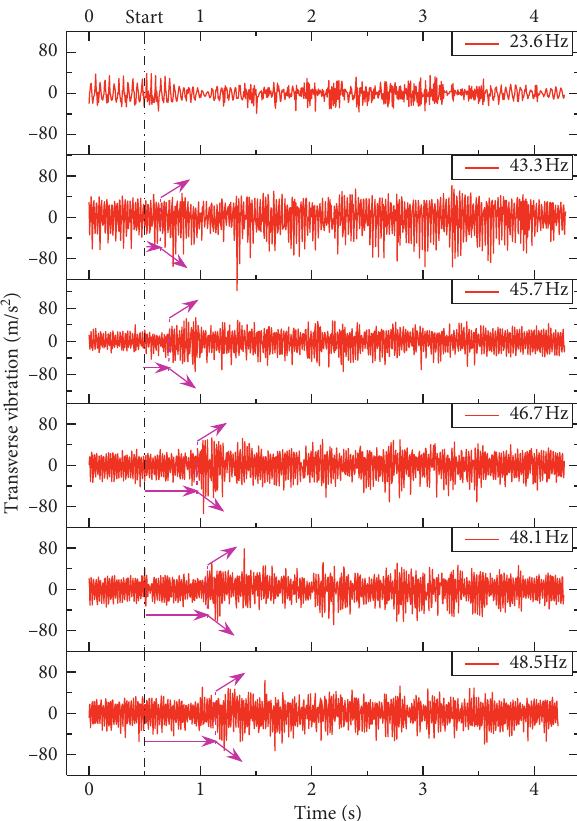
Figure 12: Transverse rope vibration under different excitation